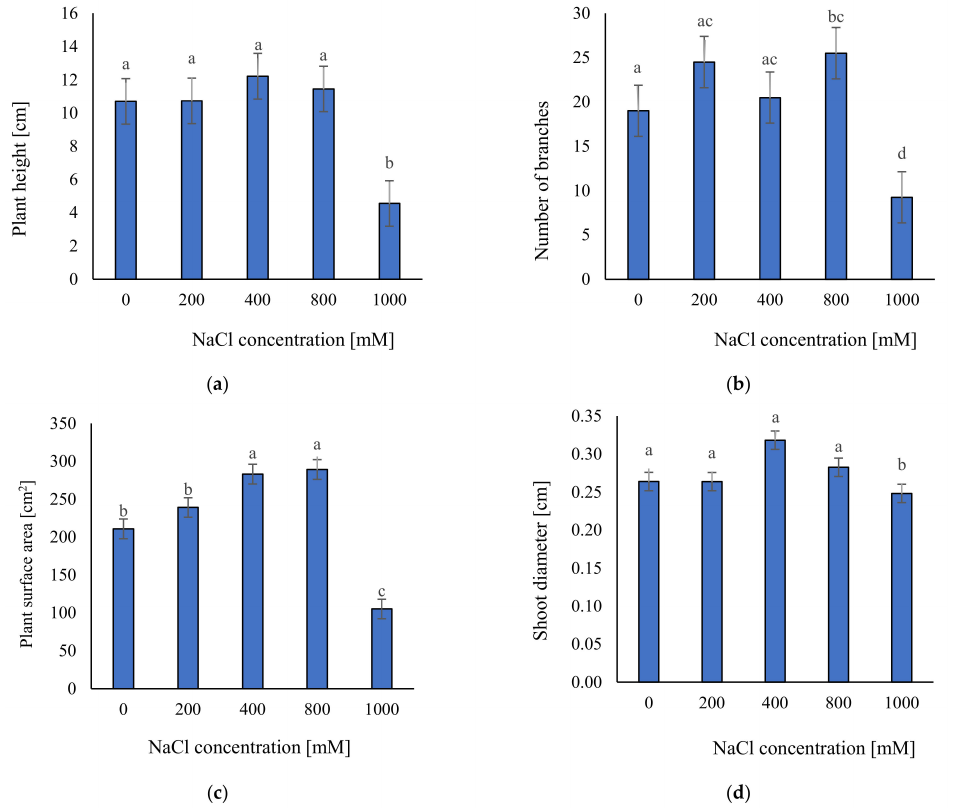
Figure 2. The average parameters of: ( a ) height; ( b ) number of branches; ( c ); surface area; ( d ) shoot diameter of the analyzed plants; ± SD (standard deviation) in the tested samples. ANOVA p < 0.001, significant differences based on post hoc Tukey’s test are marked with different